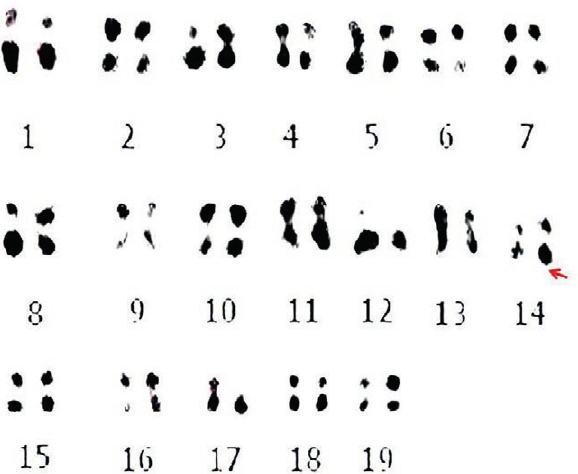
Figure 4. Chromosomes of Dasylirion cedrosanum Trel. stained with CBW banding, in which the presence of telomeric heterochro- matin is confirmed